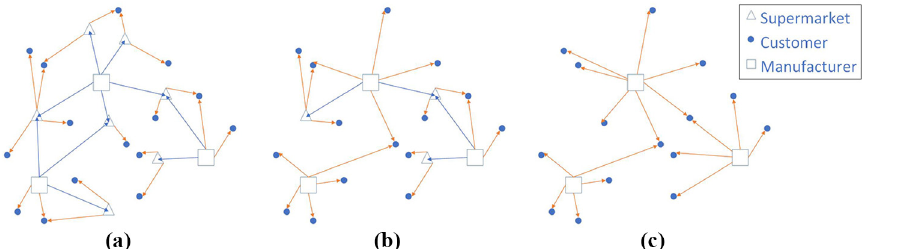
Figure 8. Production-